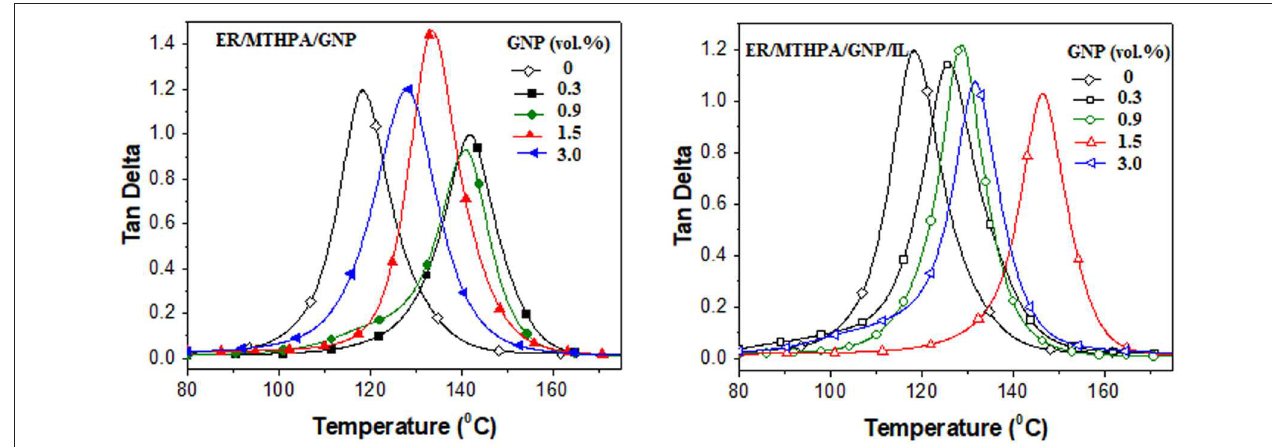
FIGURE 4 | Effect of ionic liquid and GNP content on the Tan delta of ER/GNP